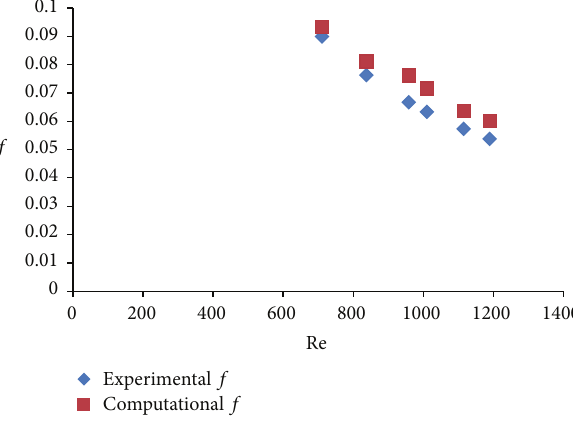
Figure 5: Friction factor versus Reynolds number for 0.87 mm ID- tube and